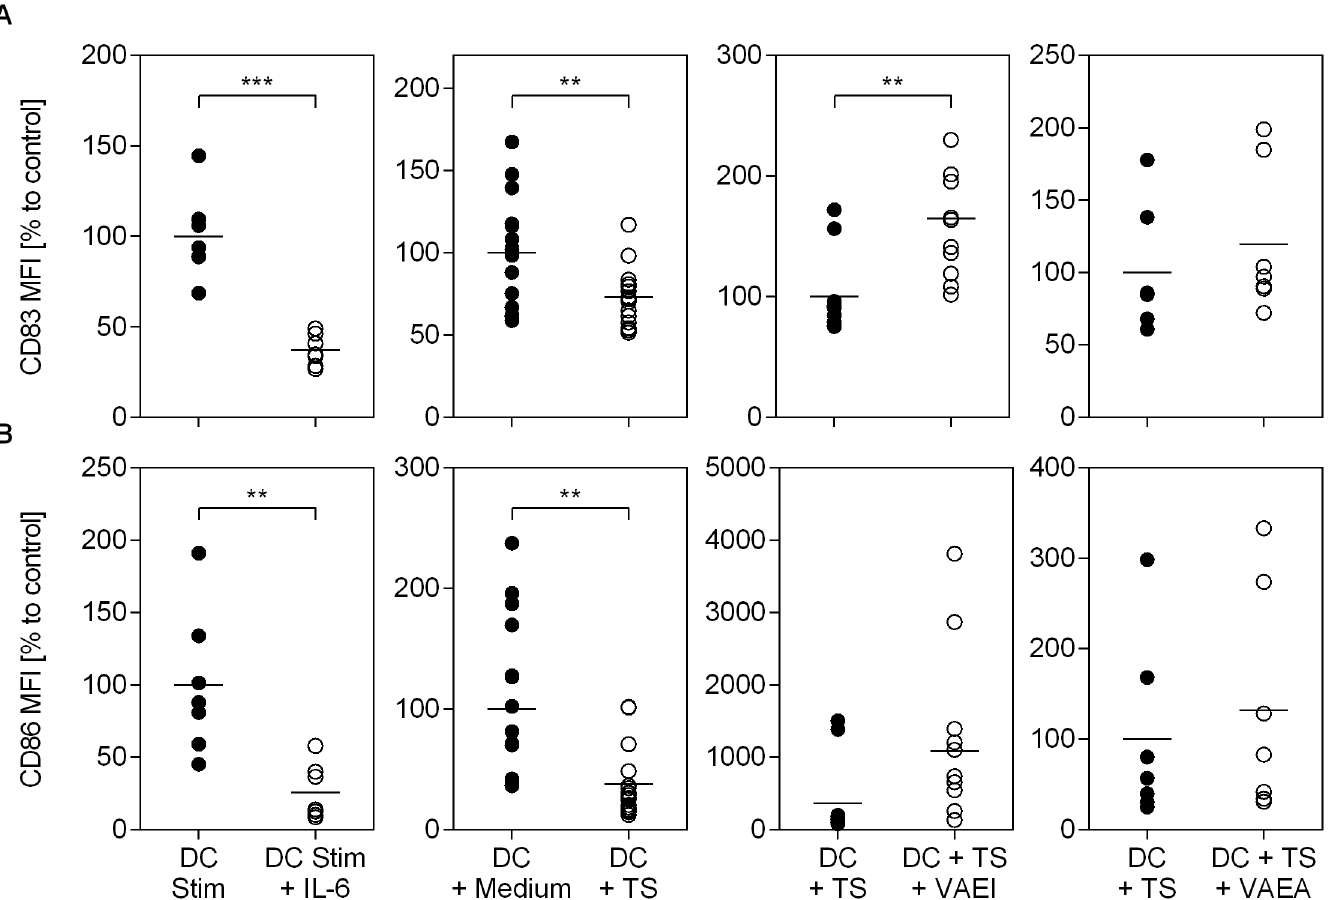
Fig 6. Effects of VAE on tumor-induced suppression of DC maturation. Dendriticcells derived from CD14 + monocyteswere stimulatedwith maturation cocktail (DC Stim; 500 ng/mL LPS; 50 ng/mL TNF-alphaand 10 ng/mL IL-1beta) and incubatedwith IL-6 as an inhibition positive control (DC Stim + IL-6; 12.5 ng/ml). Unstimulated DC were further treated with 10% RPMI 1640 medium (DC + Medium), 10% tumor supernatant of an RCC line (DC + TS) or 10% tumor supernatantand VAEI (DC + TS + VAEI; Iscador ® Qu Spez; 0.5 μ g/ml) or VAEA (DC + TS + VAEA; abnobaVISCUM ® Fraxini; 0.06 μ g/ml). DC maturation was assessedby flow cytometric analysisof CD83 (A) and CD86 (B) surface marker expression. MFI = Mean fluorescence intensity. Data and mean of 7 (IL-6 and DC + TS + VAEA), 16 (DC + TS) or 9 (DC + TS + VAEI) individualexperiments are presented in relationto stimulatedcells (DC Stim = 100%), stimulatedDC cultured in medium alone (DC + Medium = 100%)or stimulatedcells culturedwith tumor supernatant(DC + TS = 100%). Asterisks indicate significantdifferences betweenthe groups ( * P < 0.05, ** P < 0.01, *** P < 0.001).